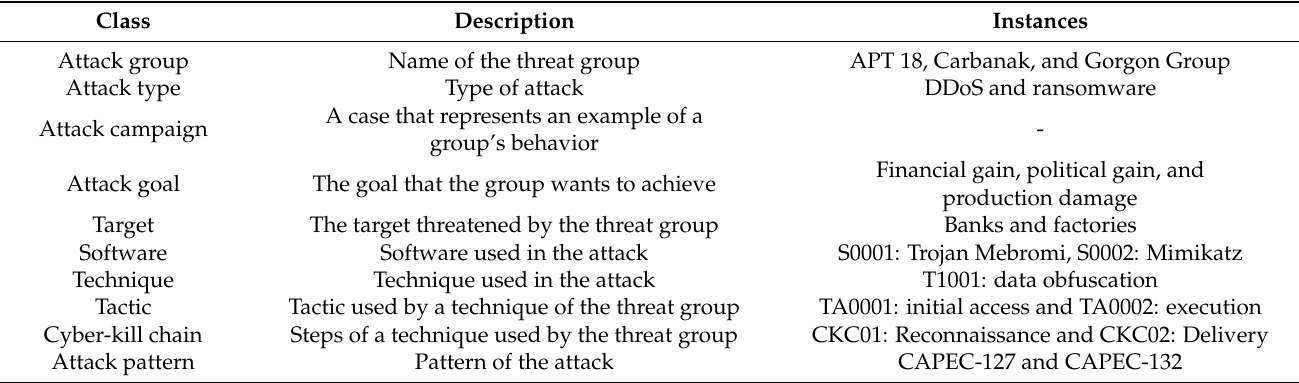
Table 1. Description of the APT component.